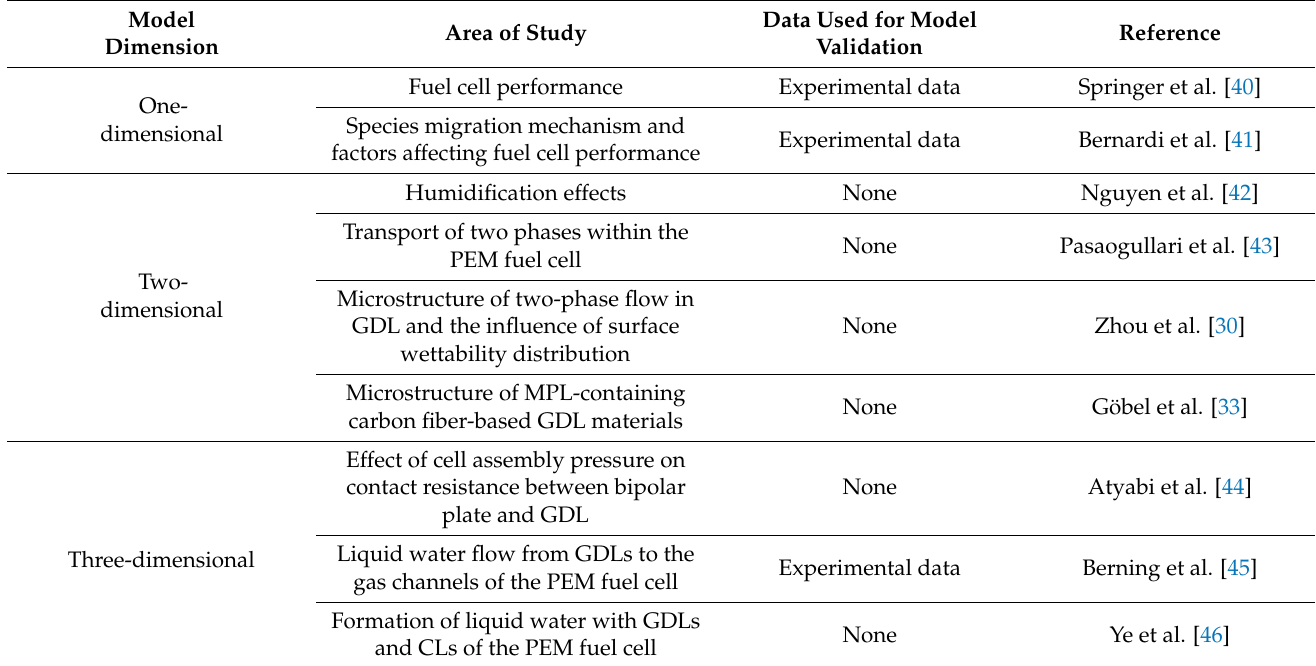
Table 1. Summary of GDL